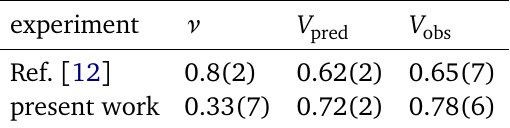
Table 1: Comparison of the visibilities in two realizations of the atomic HOM exper- iment. The column labeled ν is an estimate of the number of atoms per mode taking into account the 25 % quantum efficiency of the detector. The uncertainty in ν is that due to the detection efficiency (see text). The column V is the visibility predicted pred by Eq. (4), assuming that the number of atoms per mode is ν . The visibility observed in the experiment is V , and its uncertainty results from a fit such as shown in Fig. 4. obs